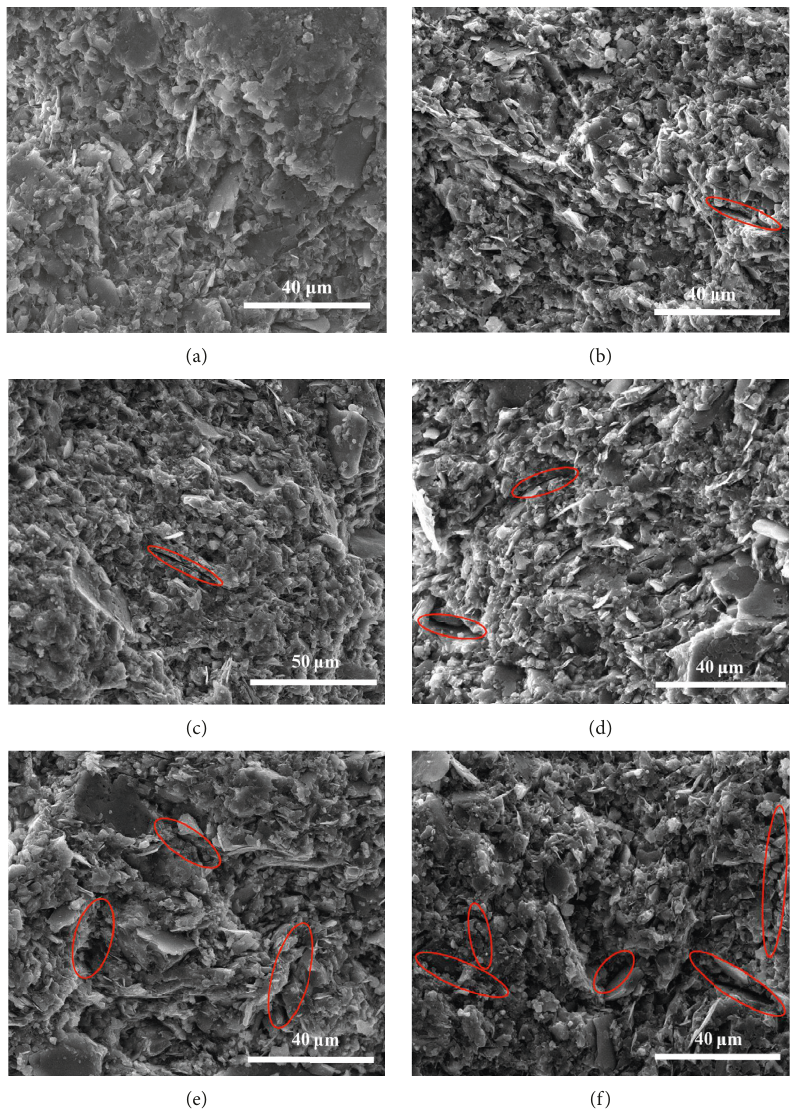
Figure 8: SEM images of argillaceous limestones after the cycle effect of wetting-drying: (a) N � 0, (b) N � 3, (c) N � 6, (d) N � 8, (e) N � 10, and (f) N � 12.